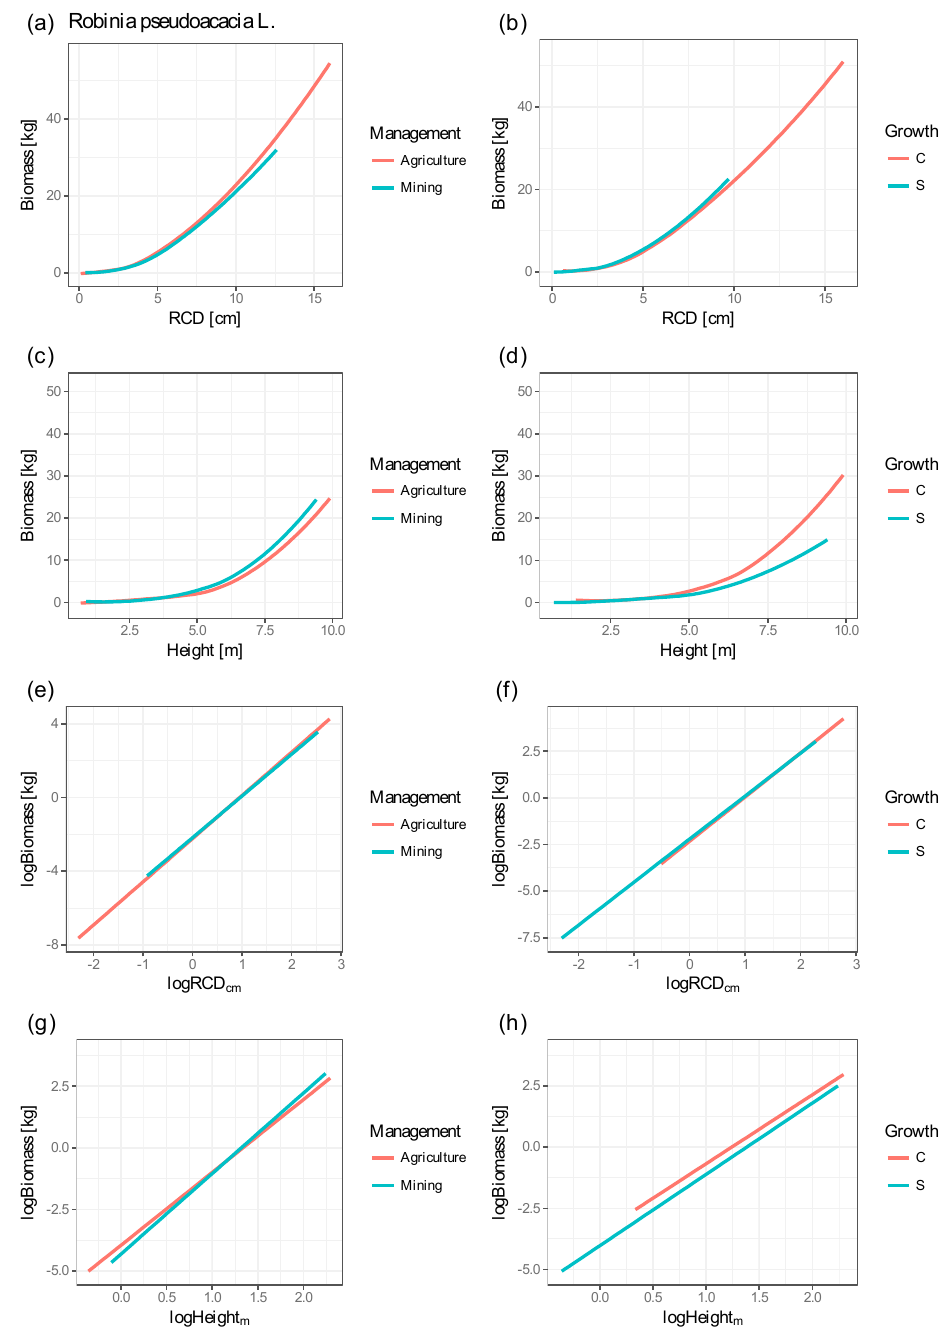
Figure 2. Allometric nonlinear least square relationship ( a – d ) and allometric relationship of double-logarithmic ( e – h ) representation between RCD (cm) and aboveground woody biomass (kg) ( a , b , e , f ), tree height (m) and aboveground woody biomass (kg) ( c , d , g , h ) separated by previous land utilization (Agriculture and Mining) and growth (C = Core and S = Stump). The statistical characteristics of the regression lines are presented in Tables 6 and 7. In Table 7, two selected values, arithmetic mean and 75% quartile (upper quartile, 25% of the largest values in the data set) of all stands, represent the differences for an individual tree (Min–Agr,